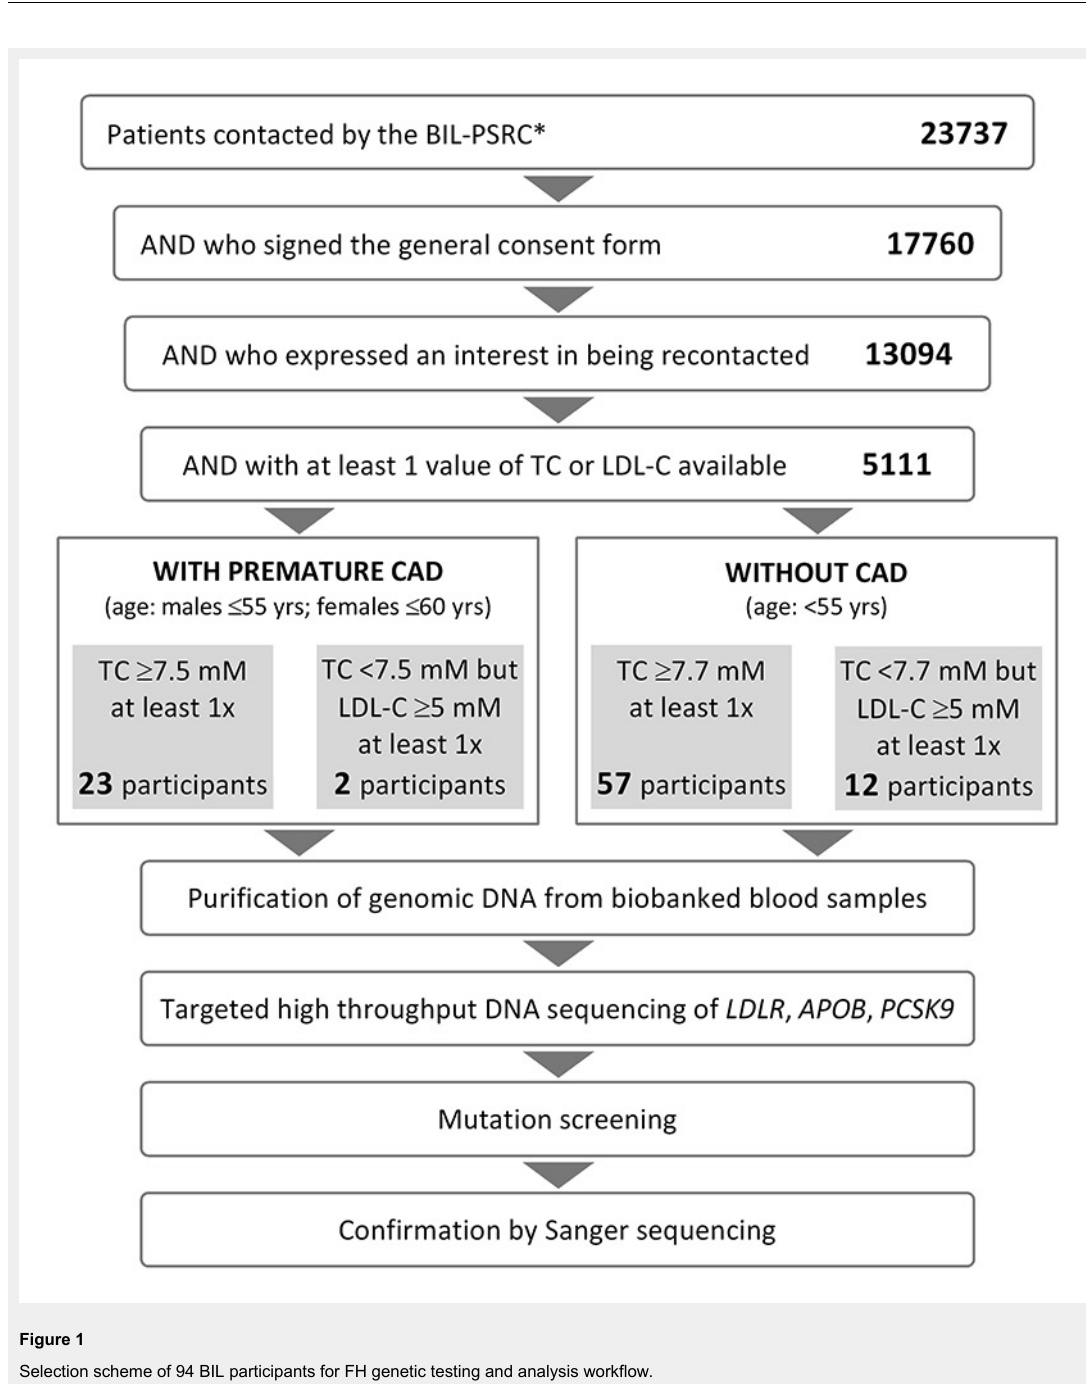
Selection scheme of 94 BIL participants for FH genetic testing and analysis workflow. *As of April 26, 2015. BIL = Lausanne Institutional Biobank; CAD = coronary artery disease; LDL-C = low-density lipoprotein cholesterol; PSRC = an integrated in- house clinical research support platform; TC = total